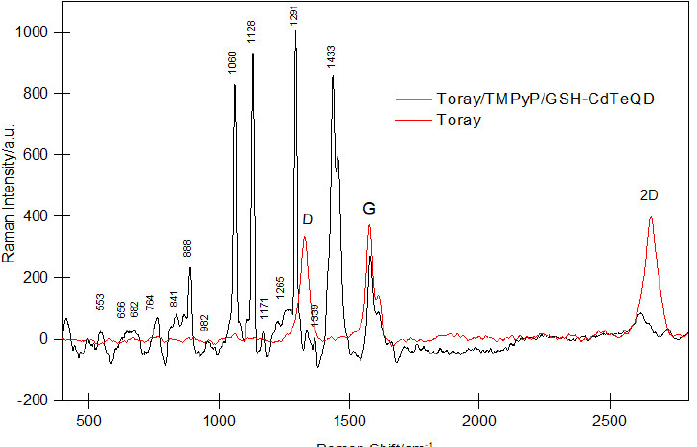
Figure 4. Raman spectra of a single Toray electrode (red line) and a TMPyP/GSH-CdTeQD modified electrode (black line). Bands D, G and 2D are labeled in their respective positions, as well as the Raman displacement value for the main bands corresponding to the active groups of the deposited material.